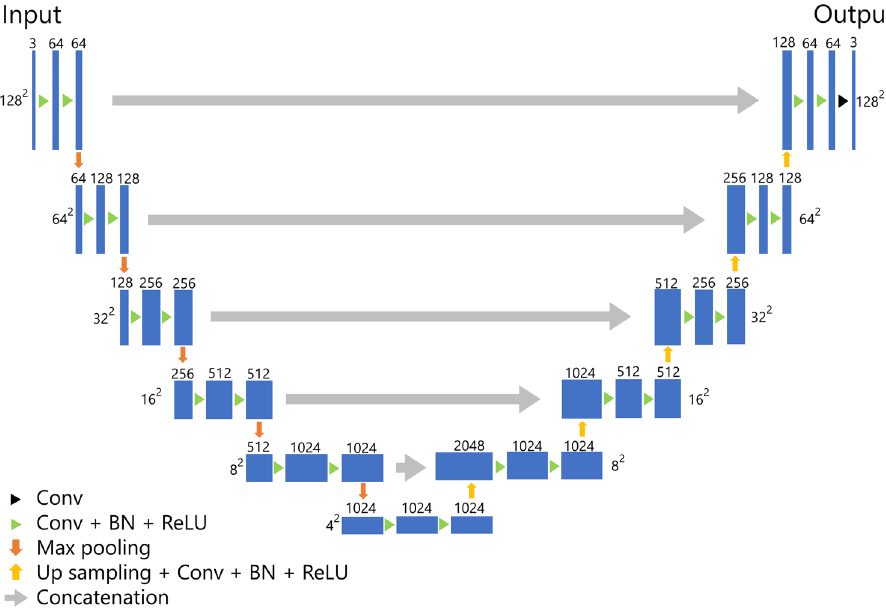
Figure 2. U-Net architecture. Conv convolution, BN batch normalization, ReLU rectified linear